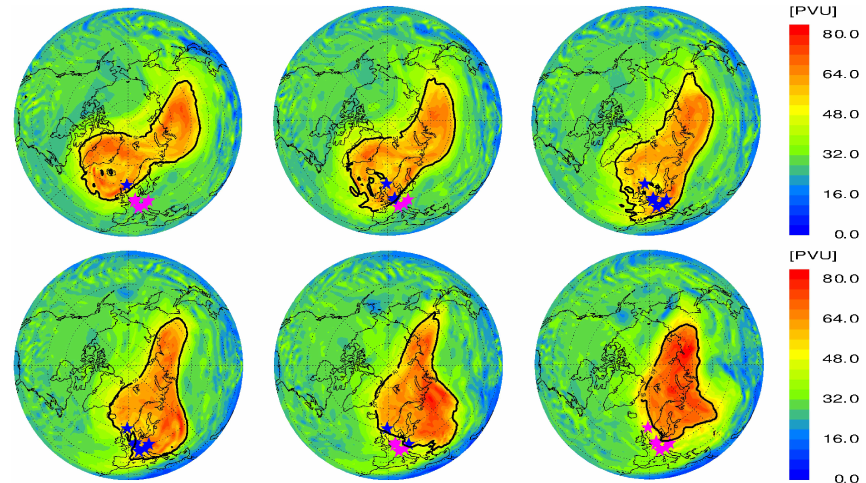
Fig. 6. Ertel’s potential vorticity (PV; × 10 − 6 Km 2 / kgs) at 2 = 500K from 16 to 18 (top row) and 19 to 21 (bottom row) January 2006, from operational analyses of ECMWF for 12:00UT; the boundary of the polar vortex (largest gradient of PV) is indicated by the thick black line; the six ozone sounding stations are marked by pink (outside vortex) and blue (inside vortex)